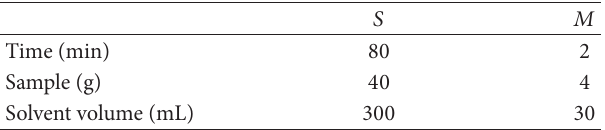
Table 4: Estimation of analysis time, amount of sample, and solvent volume for the extraction of free amino acids in twenty samples by using stomacher ( 𝑆 ) and mixer mill ( 𝑀 ).